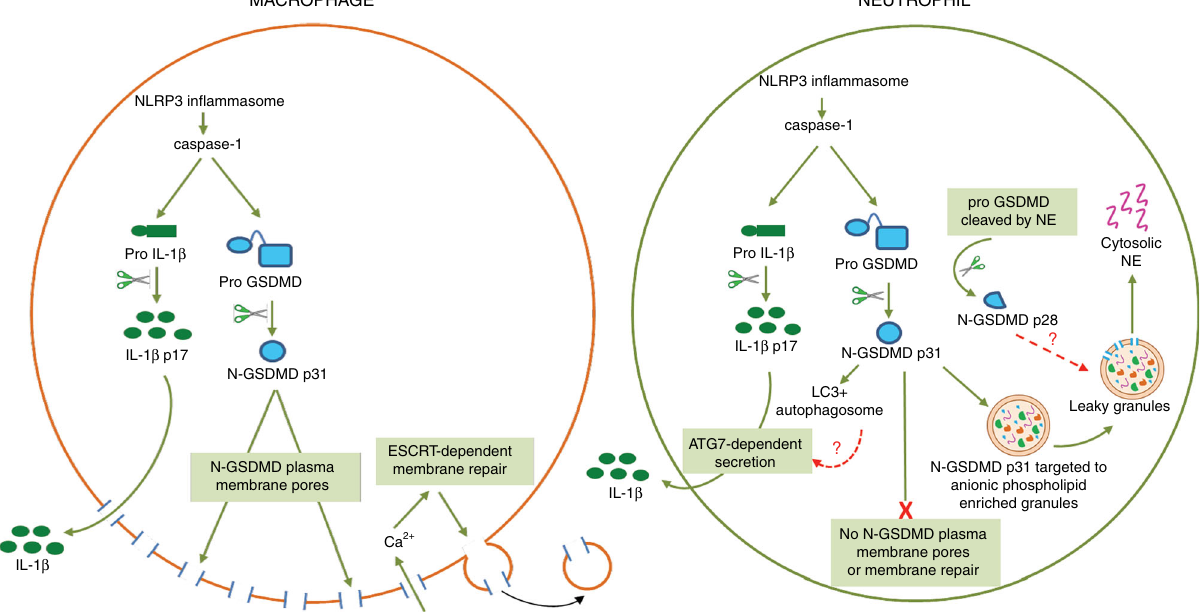
Fig. 7 Proposed model for GSDMD signaling in in fl ammasome activated neutrophils and macrophages. Comparison of NLRP3 in fl ammasome signaling and downstream GSDMD traf fi cking in neutrophils and macrophages (see text for detailed